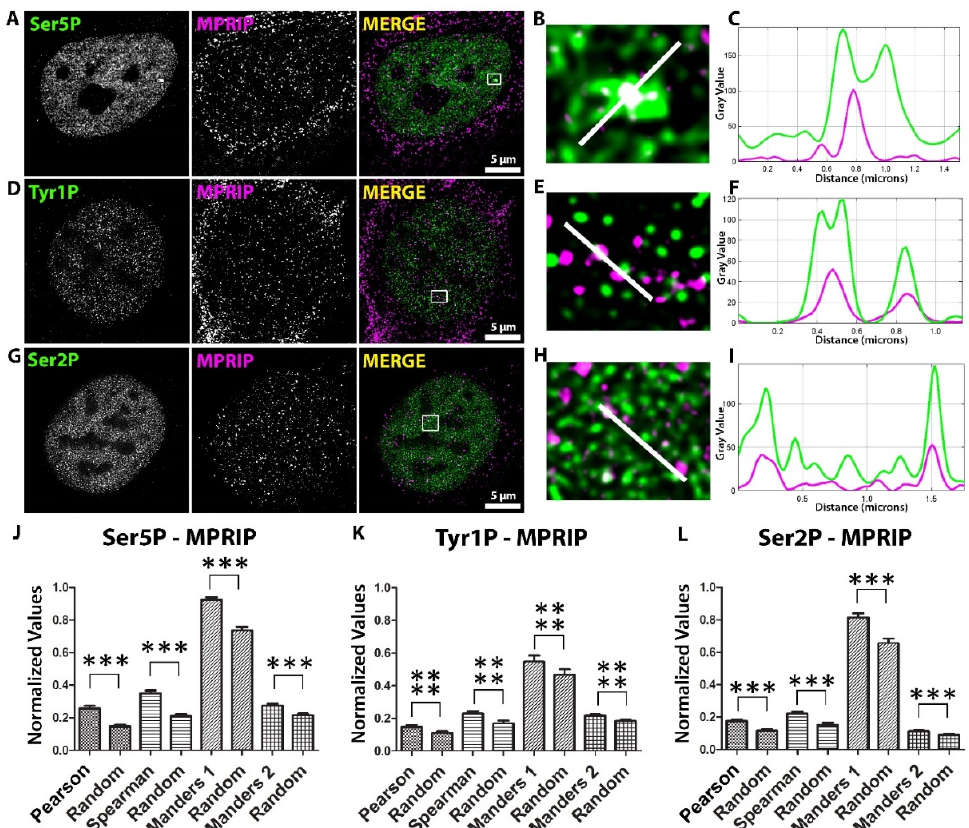
Figure 1. Mutual distribution of MPRIP and phosphorylated forms of RNAPII CTD in the cell nucleus. ( A , D , G ) Immunofluorescence labeling experiment shows the localization of endogenous MPRIP with Ser5, Tyr1 and Ser2 phosphorylated forms of RNAPII-CTD in the U2OS nucleus. Scale bars represent 5 µm. ( B , E , H ) Zoomed views of the regions that are marked by a white rectangle in the “merge” images. ( C , F , I ) The plots represent the intensities of the regions covered by the white lines on the zoomed views. ( J , K , L ) The column charts show the statistical coefficients of Pearson’s, Spearman’s, and Manders’ tests of MPRIP and phosphorylated RNAPII signal. Manders 1 analysis: MPRIP over RNAPII channel; Manders 2 analysis: RNAPII over MPRIP channel. Columns, marked as ’Random’, were obtained by analyzing randomized images (see M.M.). The triple asterisks “ *** “correspond to a significance level of p ≤ 0.001 and the quadruple asterisks “ **** ” correspond to a significance level of p ≤ 0.0001. n = 3, 15 cells/condition for each immunofluorescence experiment.